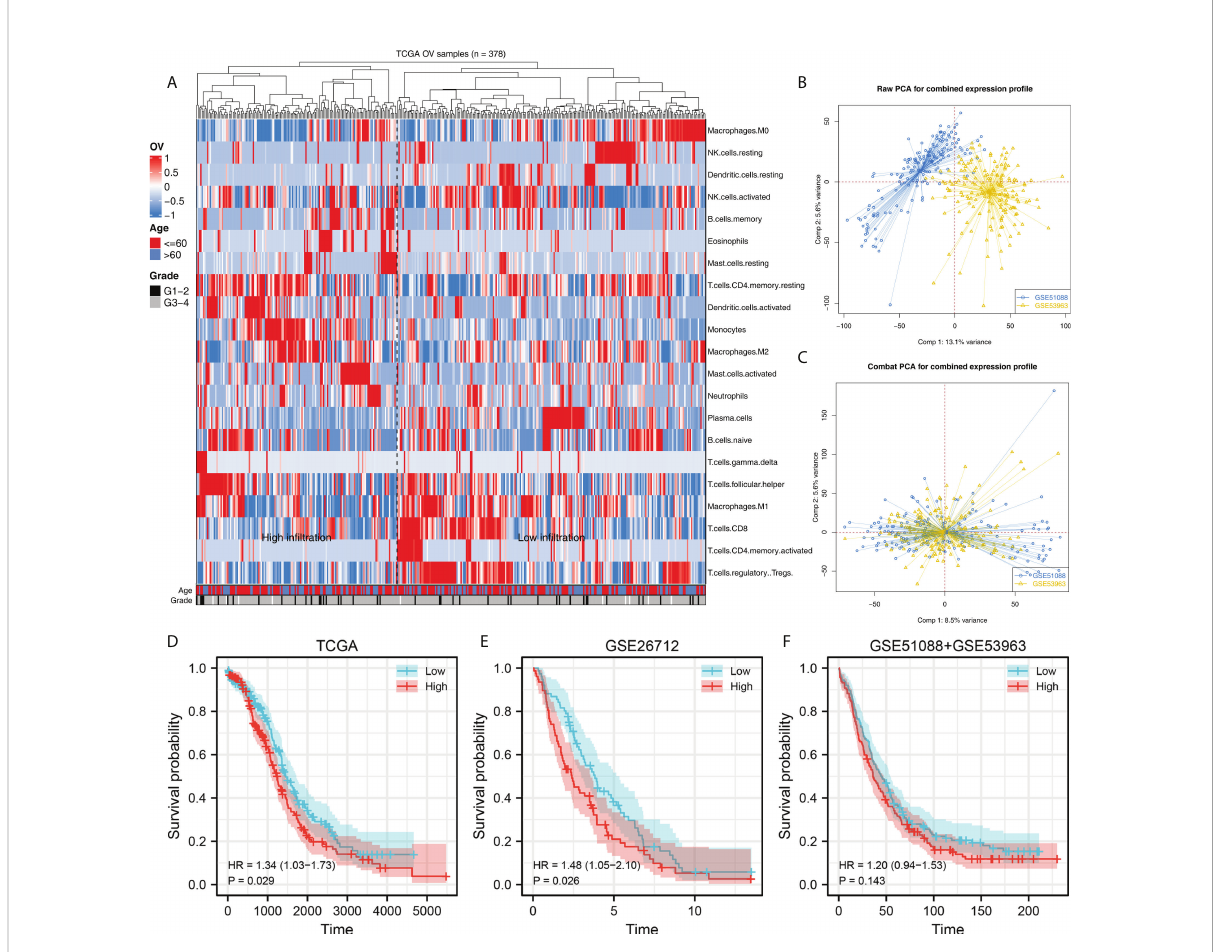
FIGURE 1 Quanti fi cation of the M2 macrophaegs in OV. (A) CIBERSORT algorithm was used to quantify the immune cell in fi ltration in TCGA-OV project; (B) GSE51088 and GSE53963 were selected for further analysis; (C) Sva package was used to combine the data of GSE51088 and GSE53963; (D – F) Kaplan-Meier survival was performed to explore the prognosis role of M2 macrophages in different